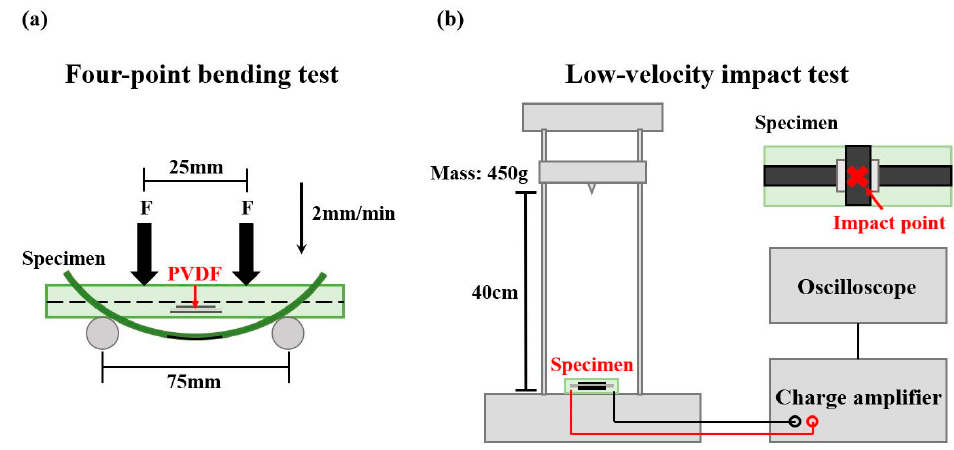
Figure 3. Experimental setup of the ( a ) four-point bending test and ( b ) low-velocity impact test.